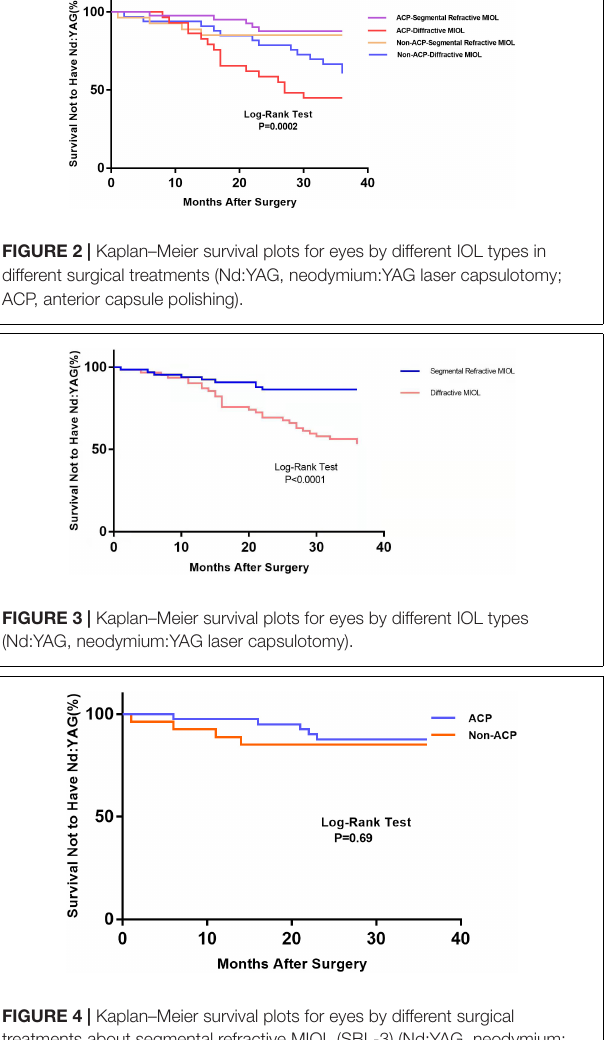
FIGURE 4 | Kaplan–Meier survival plots for eyes by different surgical treatments about segmental refractive MIOL (SBL-3) (Nd:YAG, neodymium: YAG laser capsulotomy; ACP, anterior capsule polishing).